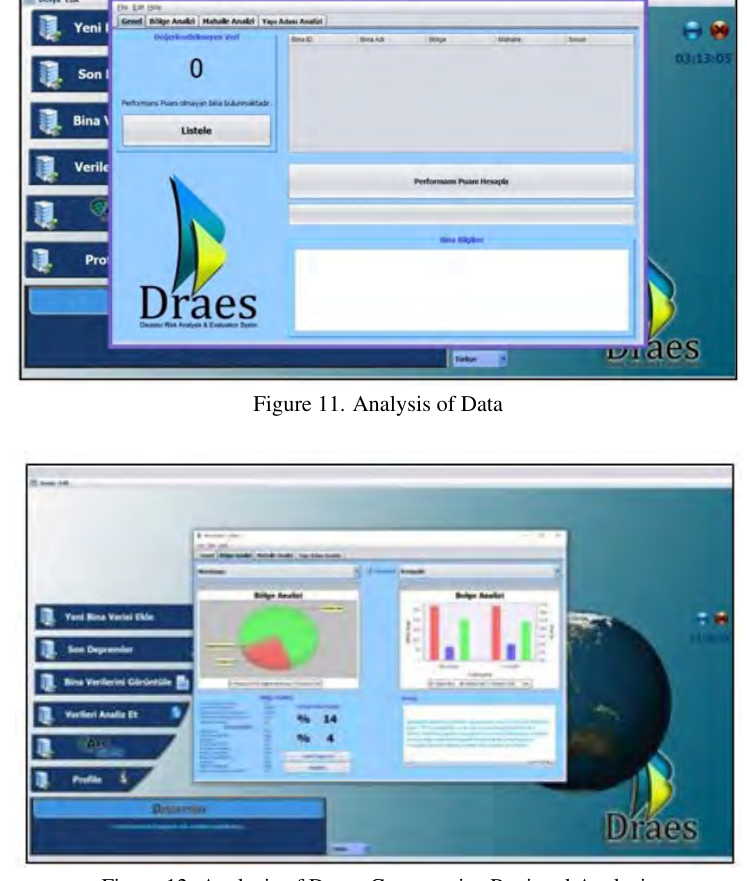
Figure 12. Analysis of Data - Comparative Regional